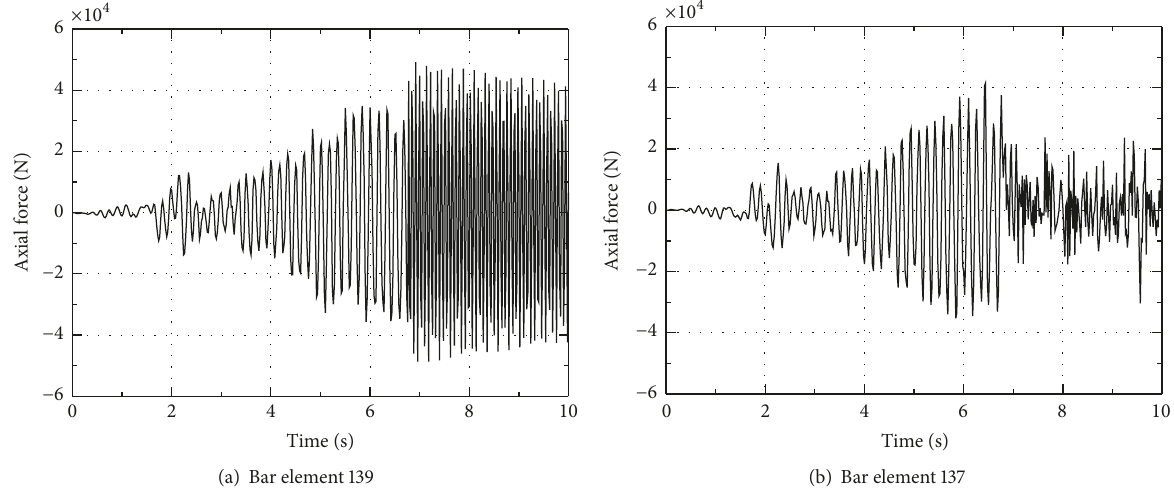
Figure 19: Axial force time history curves of bar elements 139 and 137.